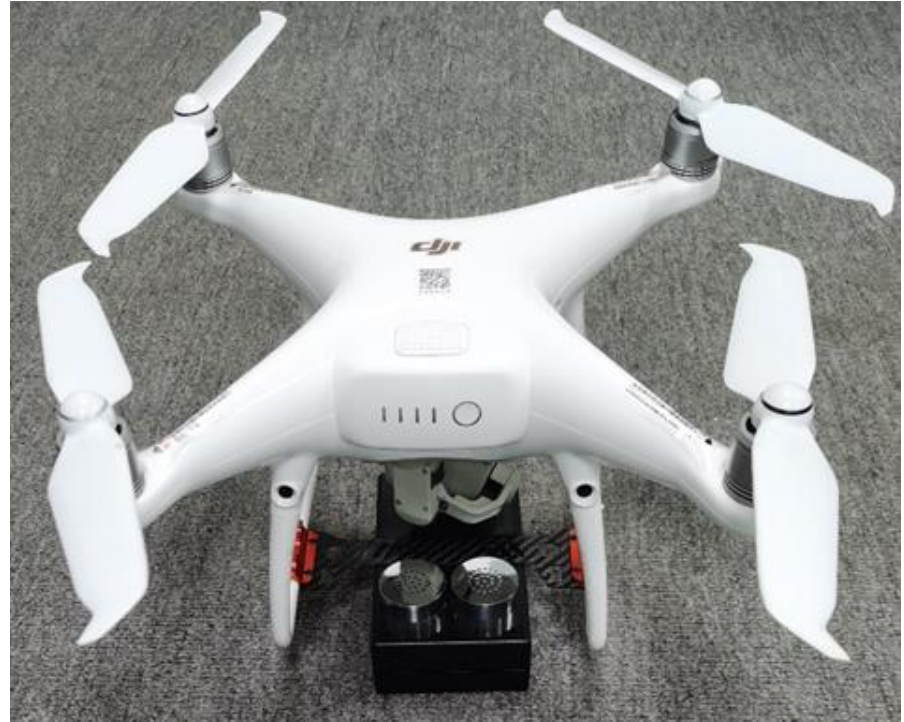
Figure 2. The ship exhaust mini-sniffing